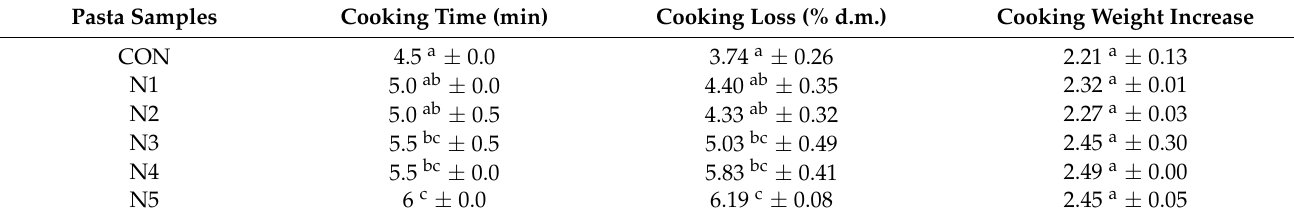
Table 5. Cooking quality of pasta